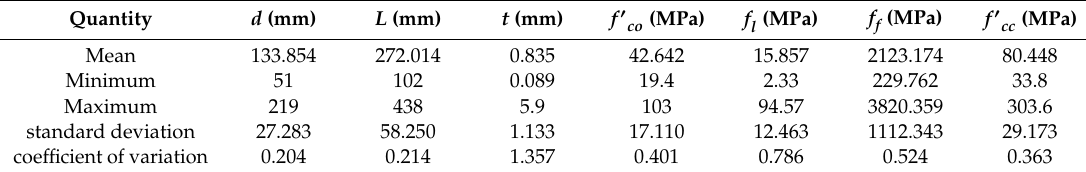
Table 3. Statistical properties for experimental data collected from the published literature.